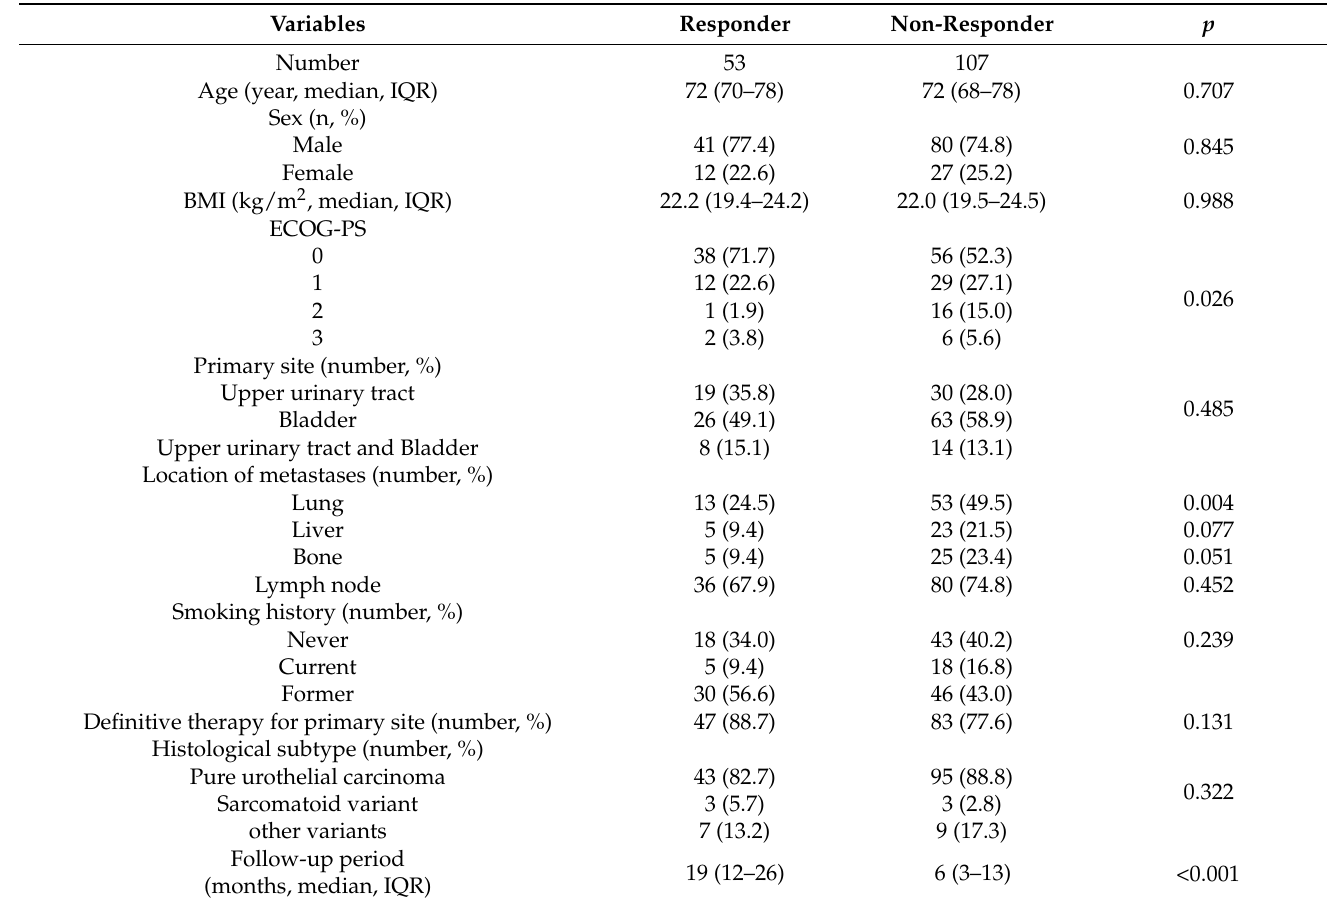
Table 1. Patient characteristics.